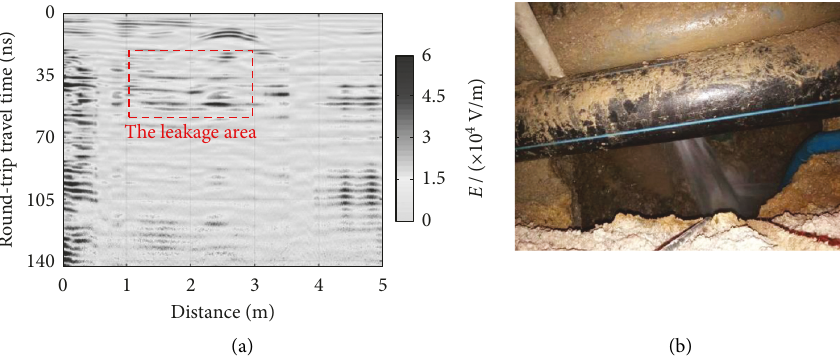
Figure 6: Detection results of the complementary line: (a) schematic diagram of electric field component interpretation, where ( E ) refers to “electric field component”; (b) photo of the leakage area at the complementary